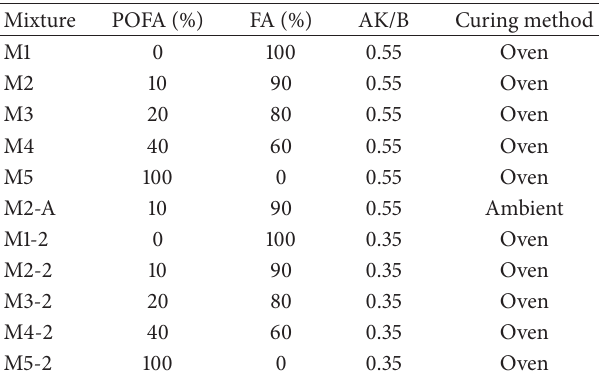
Table 3: Variables investigated on the